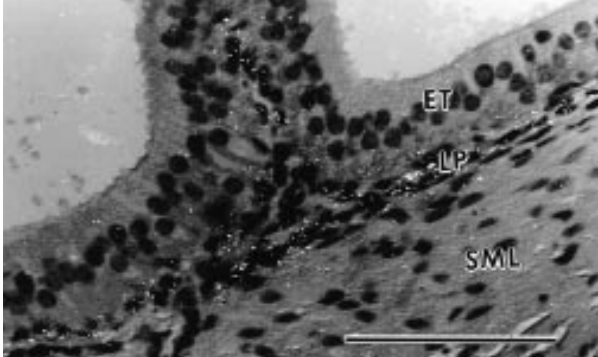
Figure 3 - Overlay image of differential interference contrast (DIC) and confocal LSM images of microradioautographs of mouse deferent duct 3 min after intravenous injection of 125 I-insulin. Numerous silver grains can be seen in the lamina propria (LP), but not in the epithelium (ET) or smooth muscle layer (SML). Bar = 50